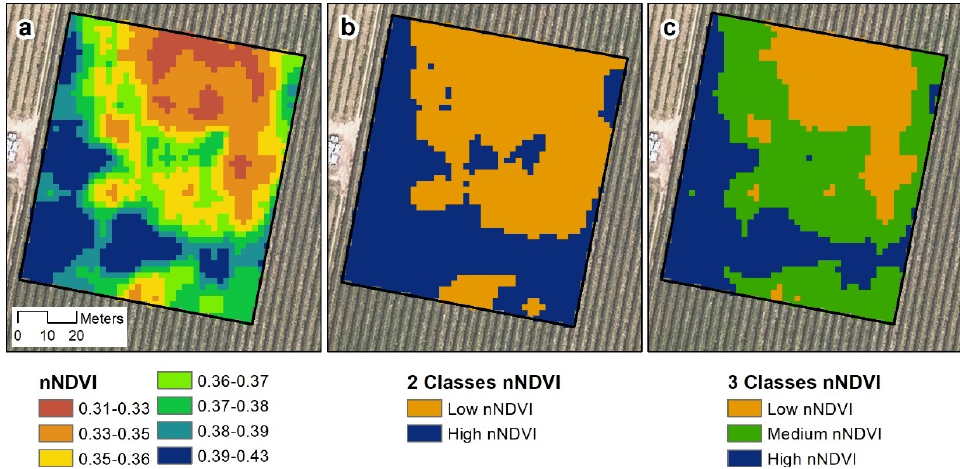
Table 6. In both two and three classes, the averages presented statistical differences with a p -value < 0.01 after the ANOVA tests.